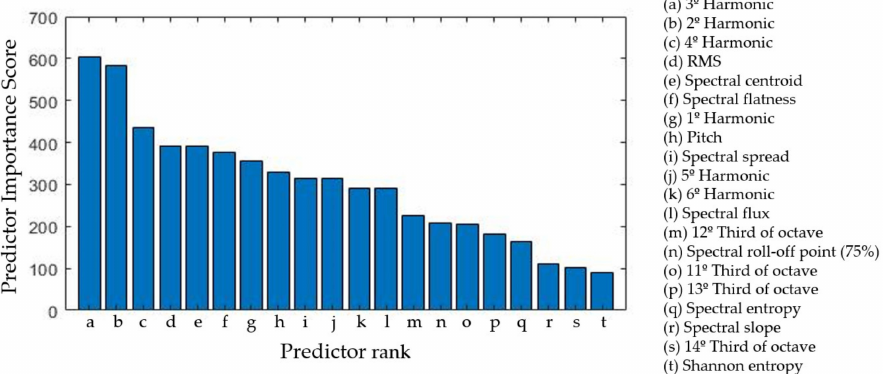
Figure 7. Predictor importance score of each feature differentiating various depths of cut